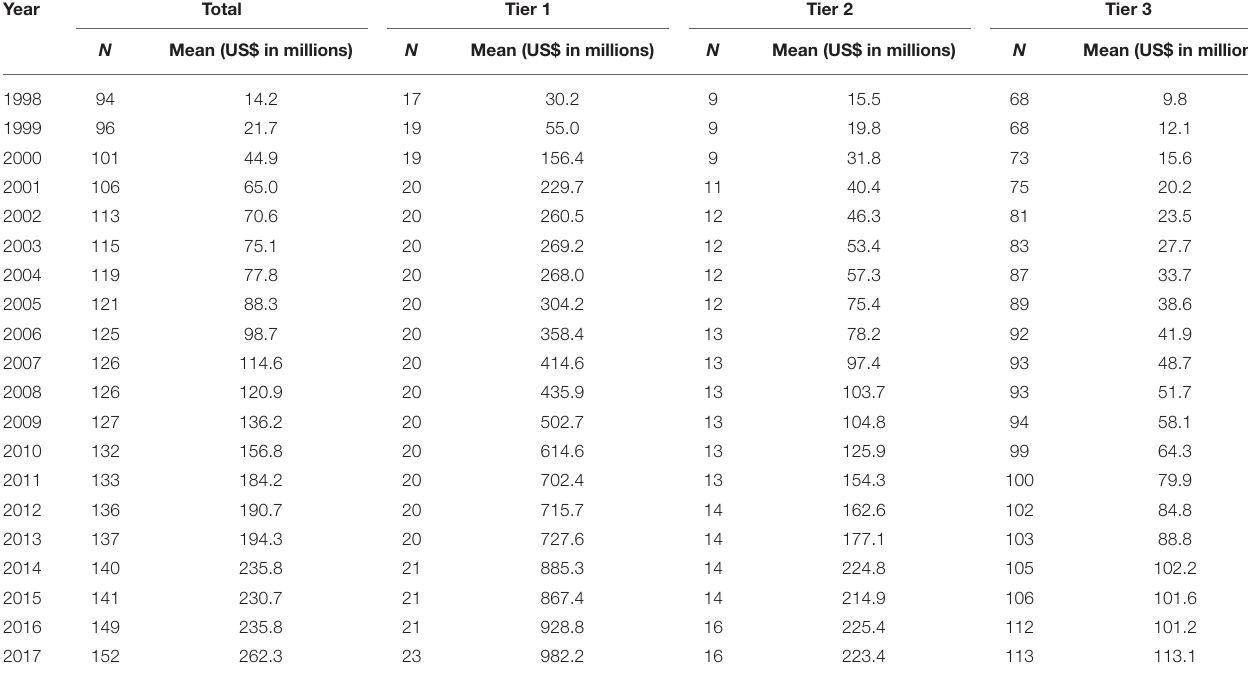
TABLE 1 | Average funding per institution by tiers of health professional institutions: